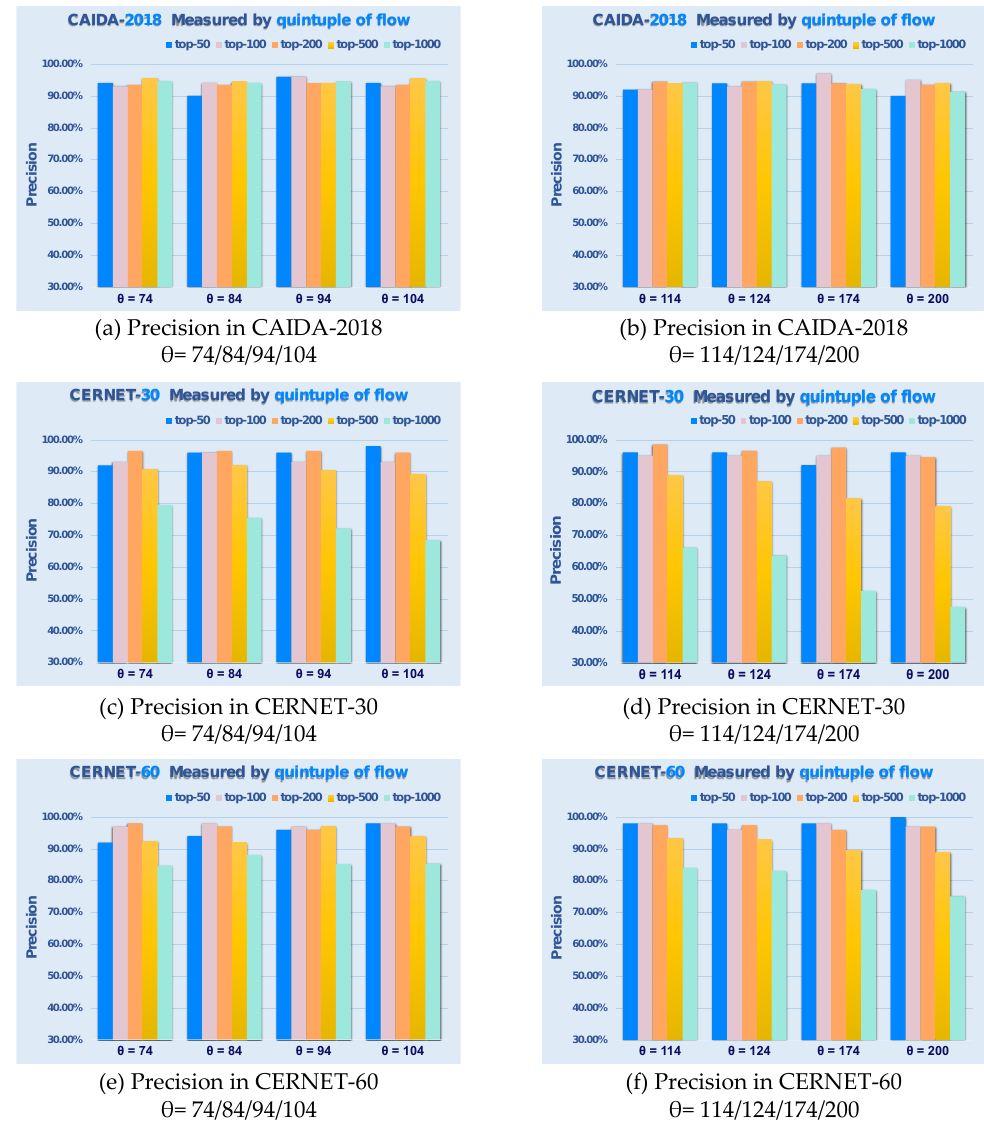
Figure 8. Experiments on precision vs. quintuple of flows. ( a ) Precision in CAIDA-2018. ( b ) Precision in CAIDA-2018. ( c ) Precision in CERNET-30. ( d ) Precision in CERNET-30. ( e ) Precision in CERNET-60. ( f ) Precision in